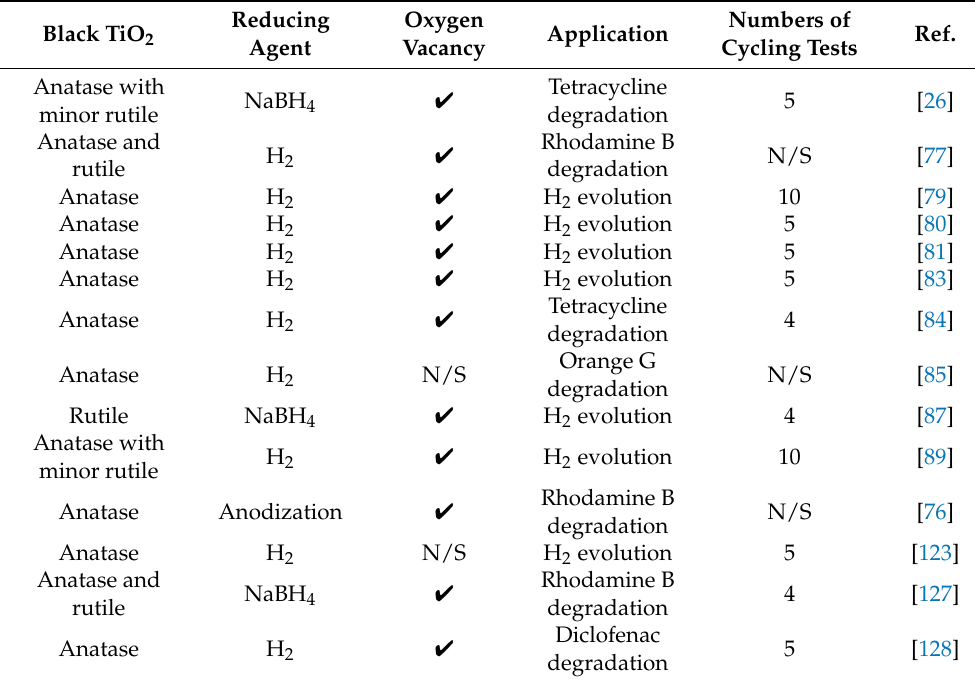
Table 2. Applications and properties of black TiO 2 nanomaterials. Black TiO